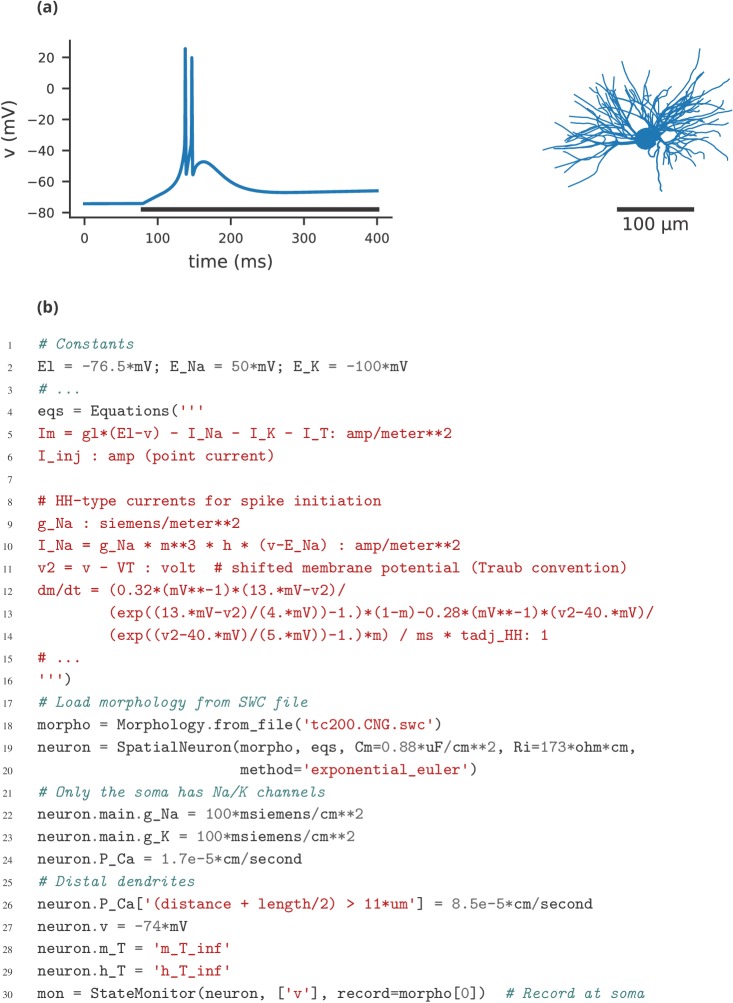
A multi-compartment model of a thalamic relay cell.(a) Simulation of a thamalic relay cell with increased T-current in distal dendrites (partially reproducing Figure 9C from Destexhe et al. (1998). The plot shows the somatic membrane potential for a current injection of 75 pA during the period marked by the black line. The model consists of a total of 1291 compartments and is based on the morphology available on NeuroMorpho.Org (Ascoli et al., 2007) under the ID NMO_00881, displayed on the right. This morphology is a reconstruction of a cell in the rat’s ventrobasal complex, originally described in Huguenard and Prince (1992). (b) Selected lines from the simulation code implementing the model shown in (a), focussing on the differences to single-compartmental models (as shown in case studies 1–4).